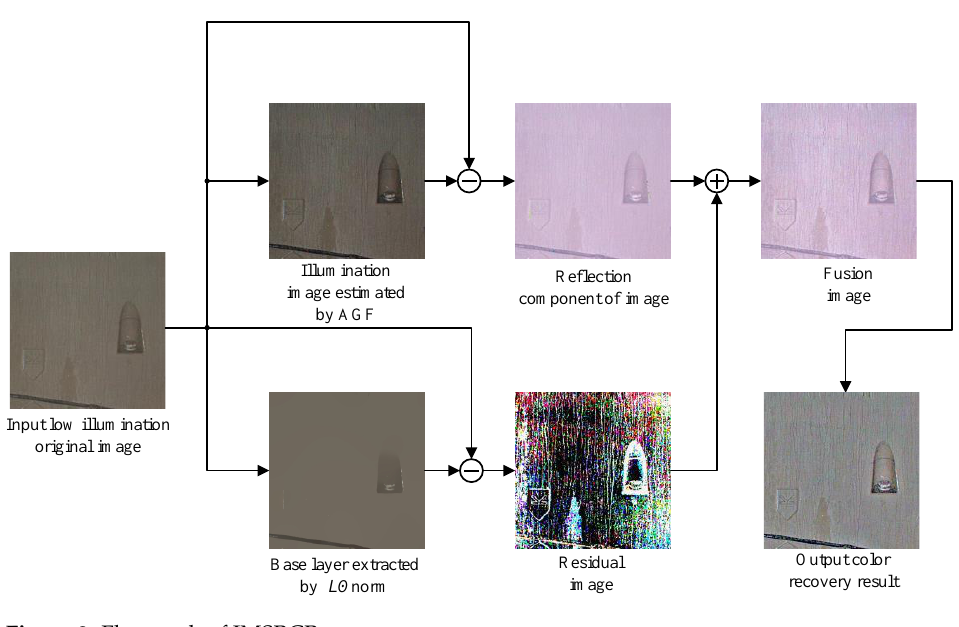
Figure 2. Flow path of IMSRCR.